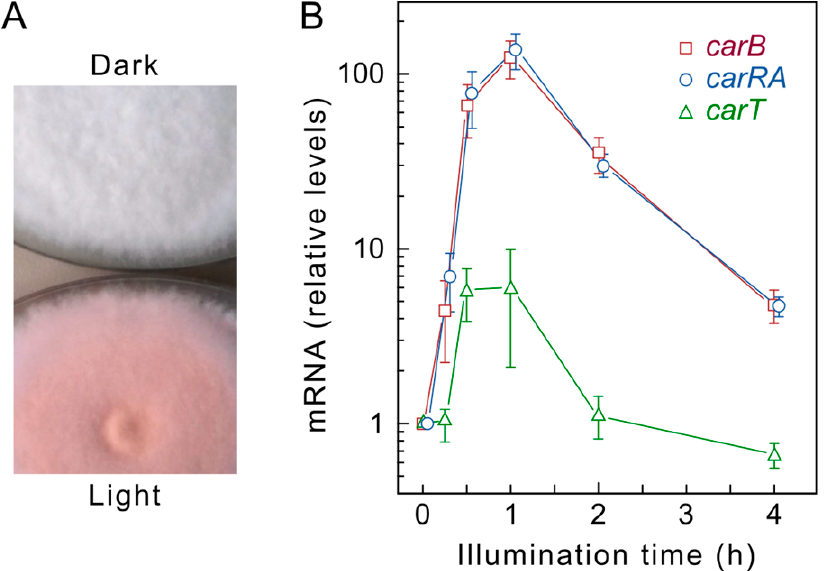
Figure 2. Photoinduction of carotenogenesis in F. fujikuroi . ( A ) Aspect of 7-day old colonies of the wild type IMI58289 grown on minimal medium in the dark or under continuous illumination; ( B ) Example of the kinetics of mRNA accumulation for the genes carRA , carB, and carT in the wild type FKMC1995. Transcript levels were determined by RT-qPCR (real time quantitative PCR) and referred to those of β -tubulin gene. Levels in the dark for each gene were taken as 1 (adapted from